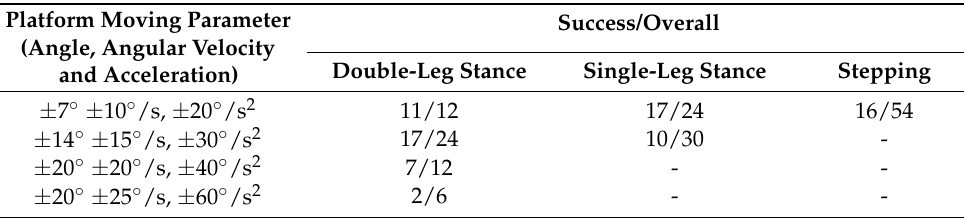
Table 9. Parameters and results of stability training experiments. Platform Moving Parameter